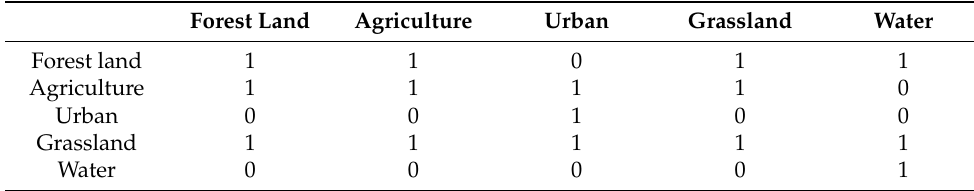
Table 1. Conversion matrix for the Dyna-CLUE model in the BRB. Forest Land Agriculture Urban Grassland Water Forest land 1 1 0 1 1 Agriculture 1 1 1 1 0 Urban 0 0 1 0 0 Grassland 1 1 1 1 1 Water 0 0 0 0